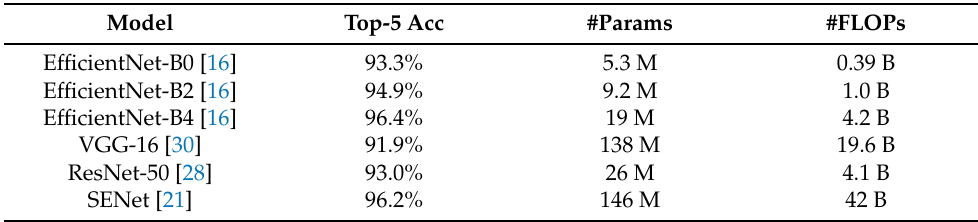
Table 1. Comparison of image classification efficiency based on the ImageNet dataset [29]: Efficient- Net models [16] versus classical models. Model Top-5 Acc